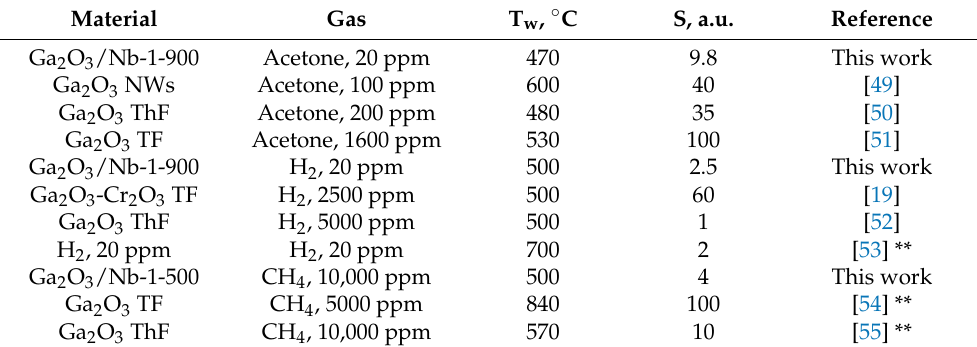
Table 3. Sensor response of various Ga 2 O 3 -based materials towards gases and VOCs